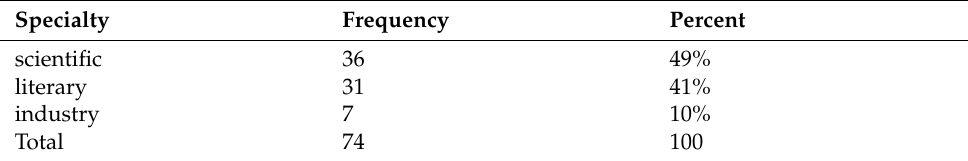
Table 2. Participant response rate by specialty.